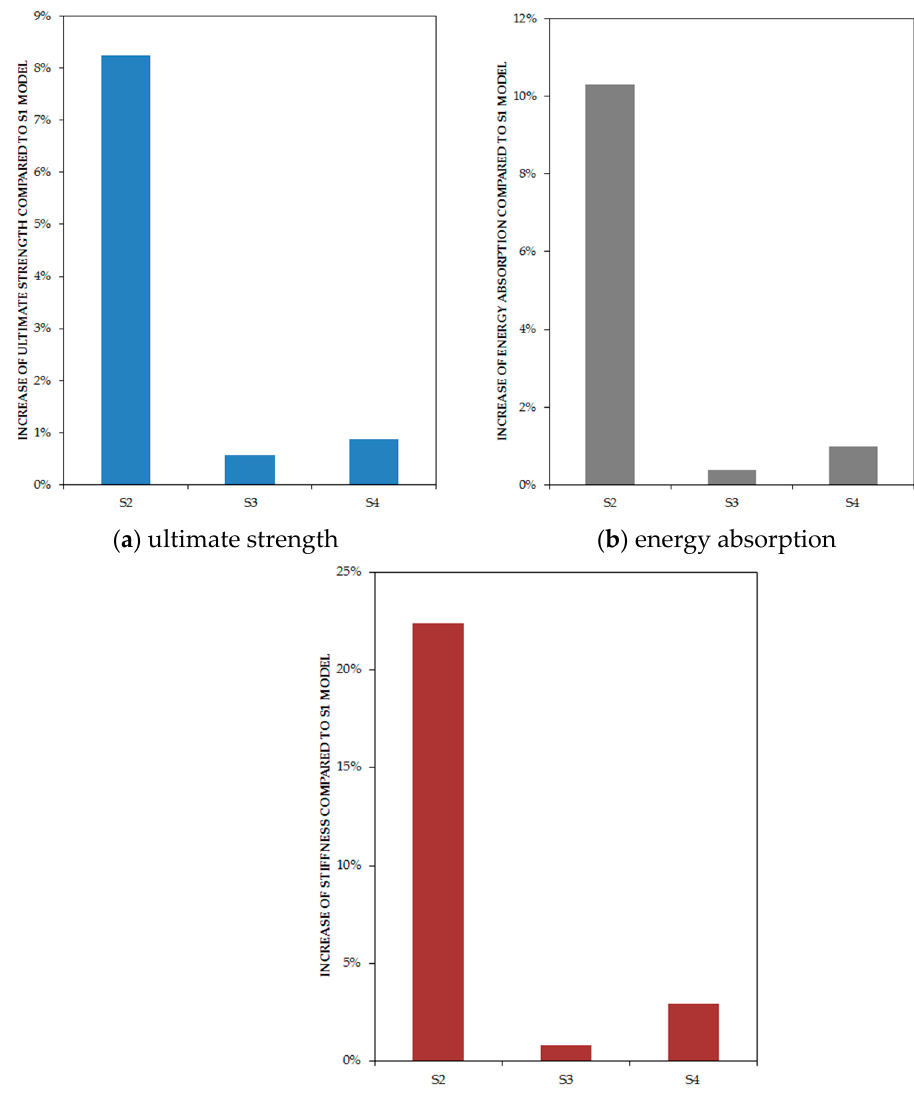
Figure 12. Increase in fundamental factors of FE models based on the stiffness of boundary elements in comparison with S1 model by percentage.